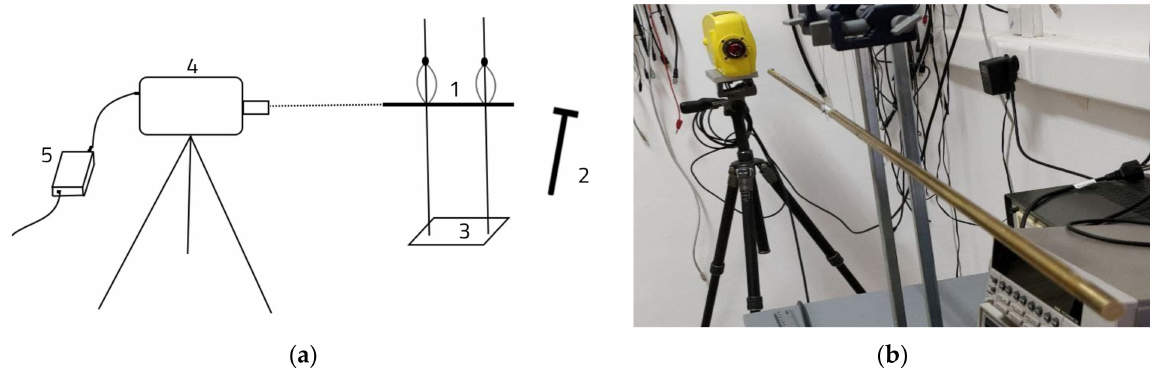
Figure 4. The experimental set-up: ( a ) the principle of experimental determination of the natural frequency of the standard bar used for the intrinsic transfer matrix. Legend: 1—sample; 2—impact hammer; 3—holder; 4—vibrometer; 5—data acquisition device; ( b ) the experimental